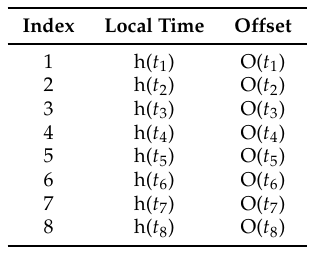
Table 2. Regression table of a